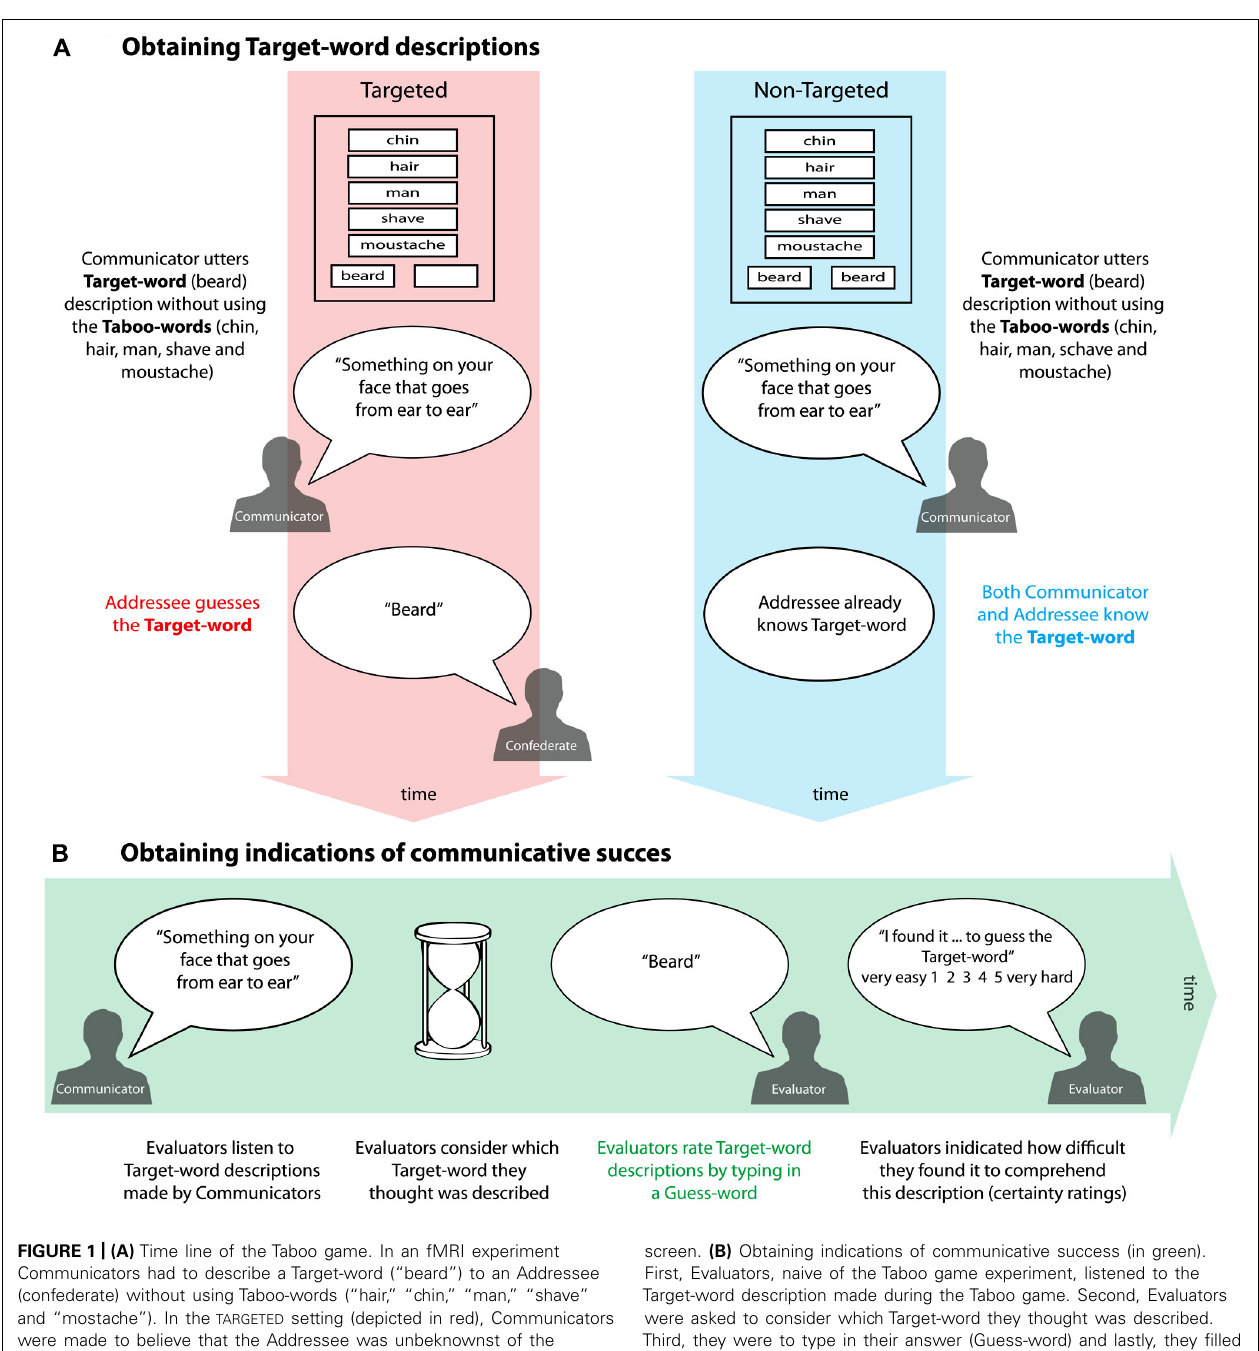
screen. (B) Obtaining indications of communicative success (in green). First, Evaluators, naive of the Taboo game experiment, listened to the Target-word description made during the Taboo game. Second, Evaluators were asked to consider which Target-word they thought was described. Third, they were to type in their answer (Guess-word) and lastly, they filled out how difficult they found it to come up with their answer on a scale from one till five (1 “easy,” 5 “difficult”; certainty scores). A measure of Communicators’ success was obtained by counting the Evaluators’ correct guesses divided by the total amount of trials per condition.